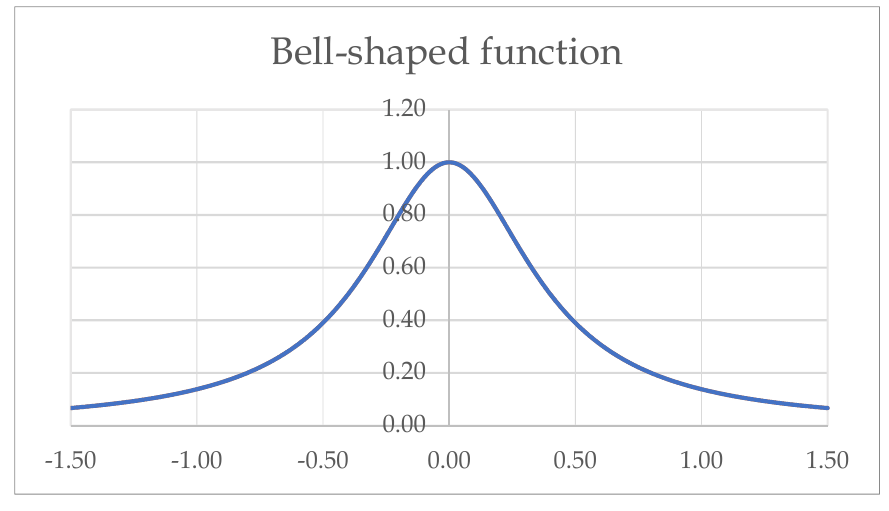
Figure 4. Bell-shaped function for a = 0 and b = 1.